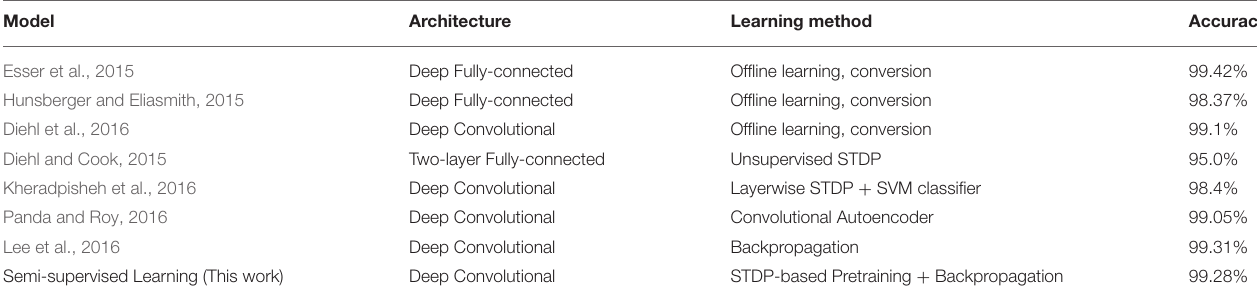
TABLE 3 | Comparison of the SNNs classification accuracies on MNIST digit recognition